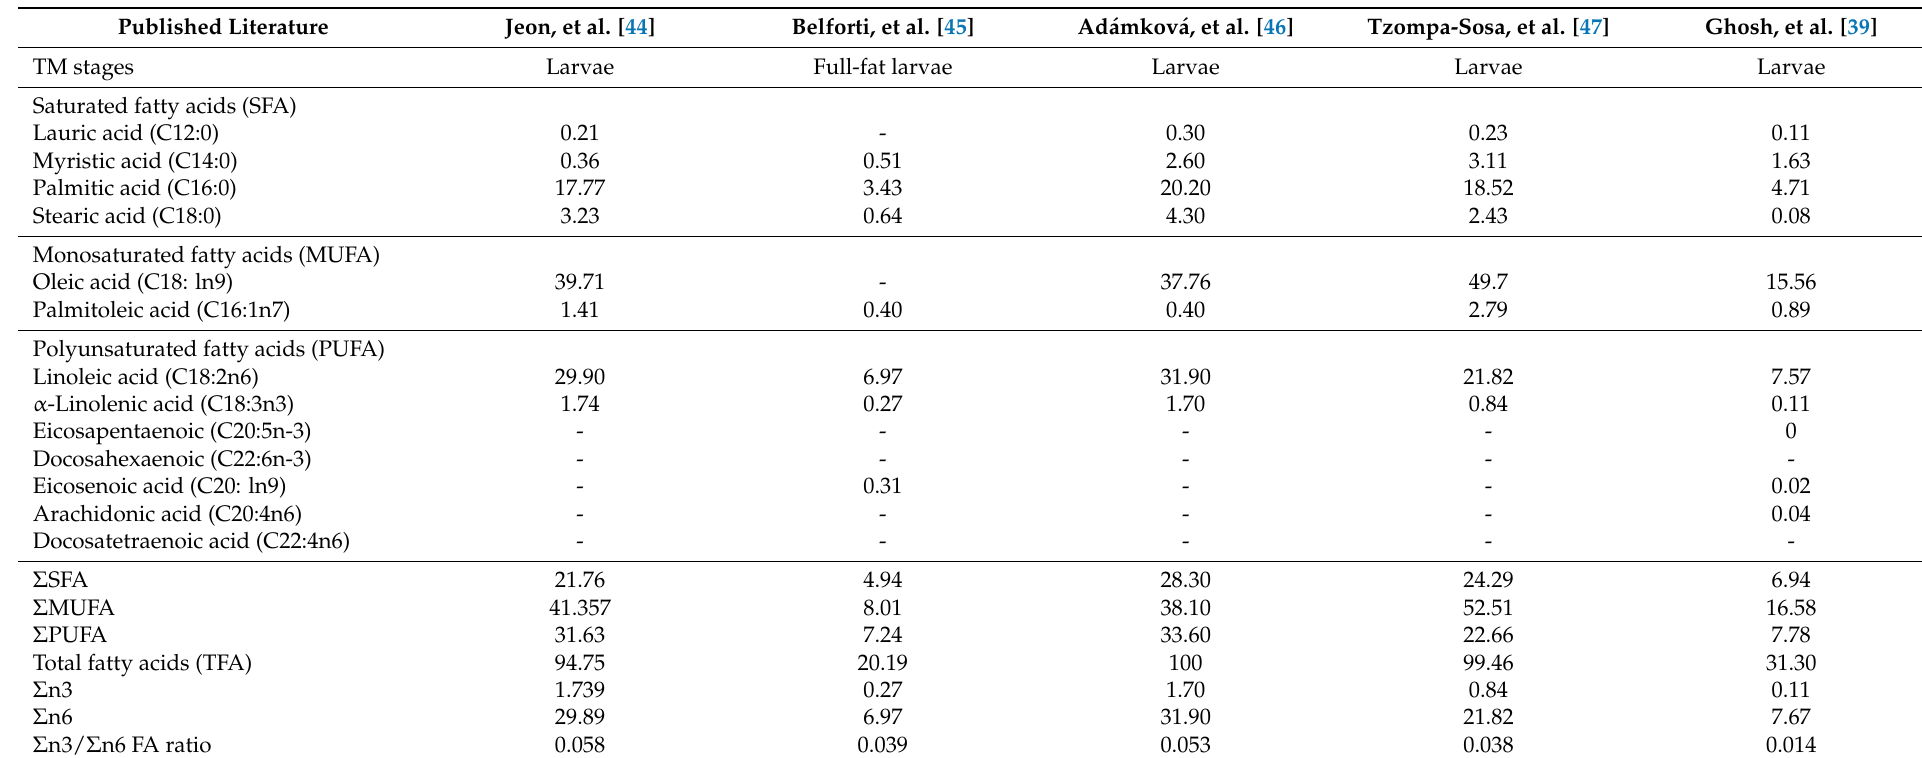
Table 3. Fatty acid composition of the yellow mealworm ( Tenebrio molitor ) (g/100 g of DM) according to the previously published